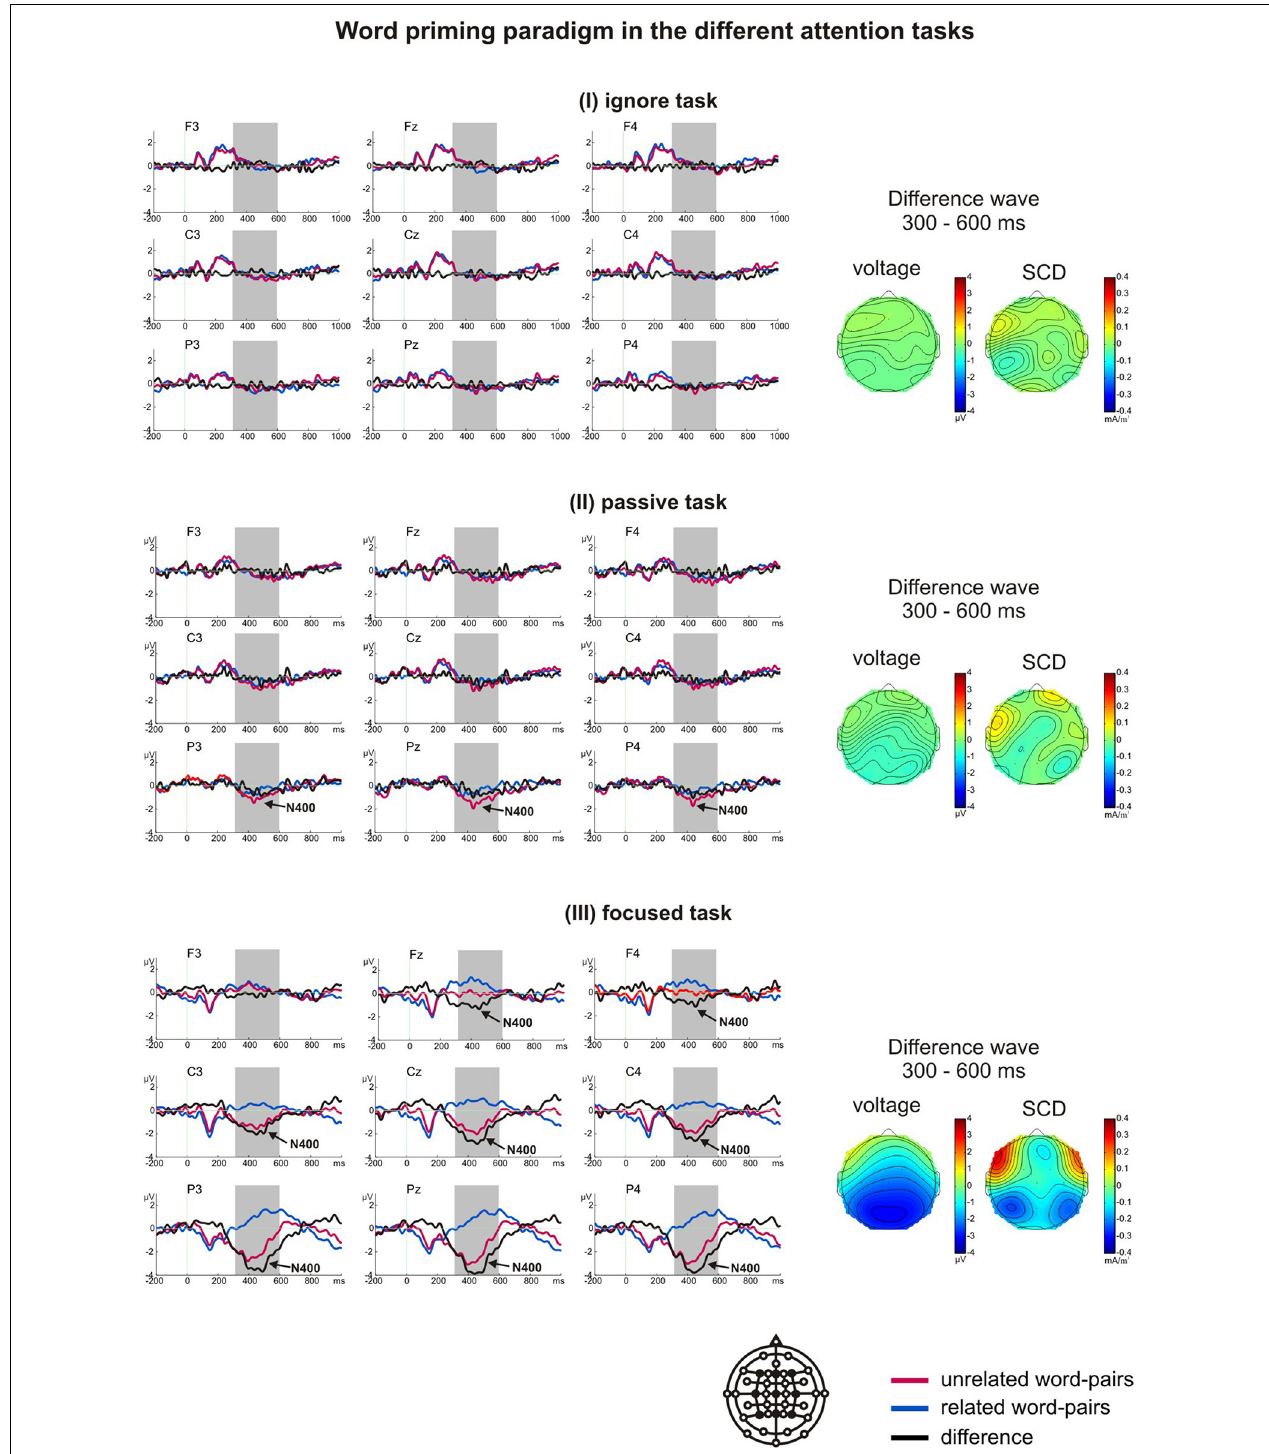
FIGURE 3 | Grand average ERPs of the word priming paradigm in the ignore task (I), passive task (II) and focused task (III). The arrows indicate whether the N400 was significantly different from zero within the analyzed